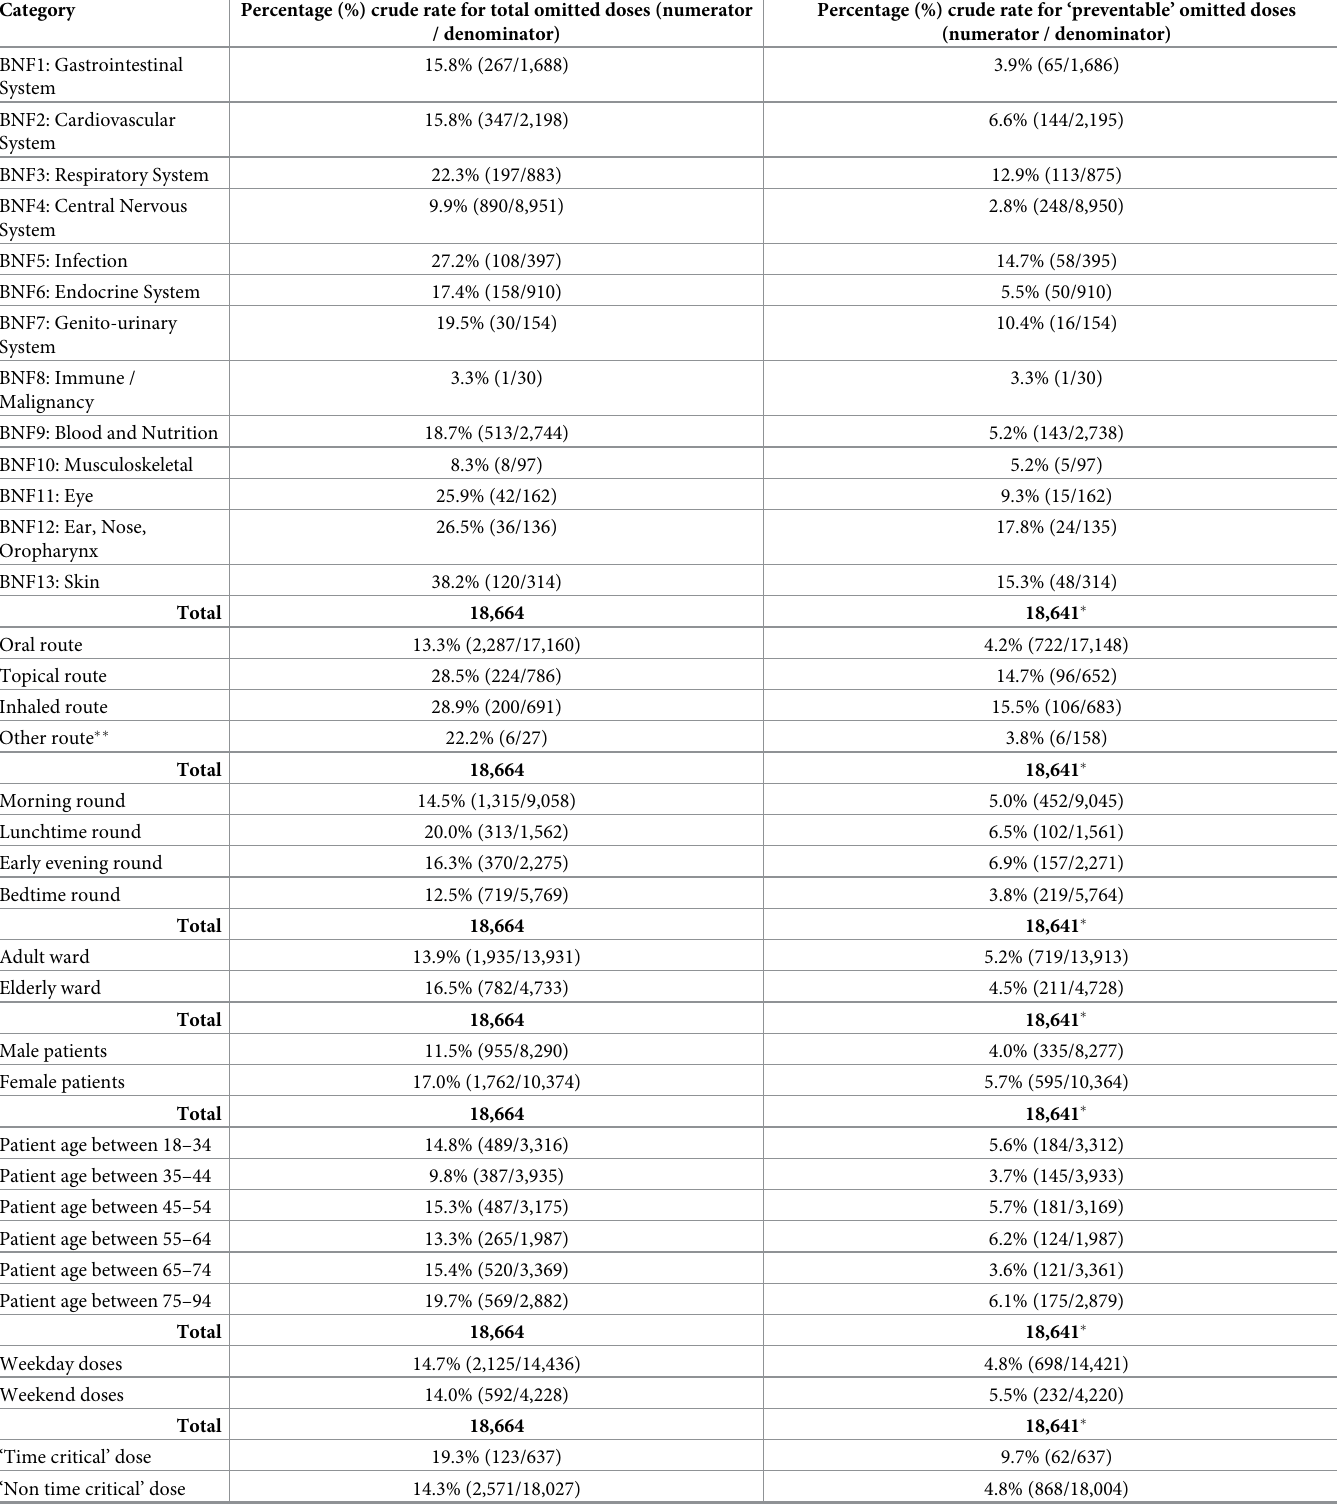
Table 1. Crude rate of total and ‘preventable’ omitted doses across subcategories.